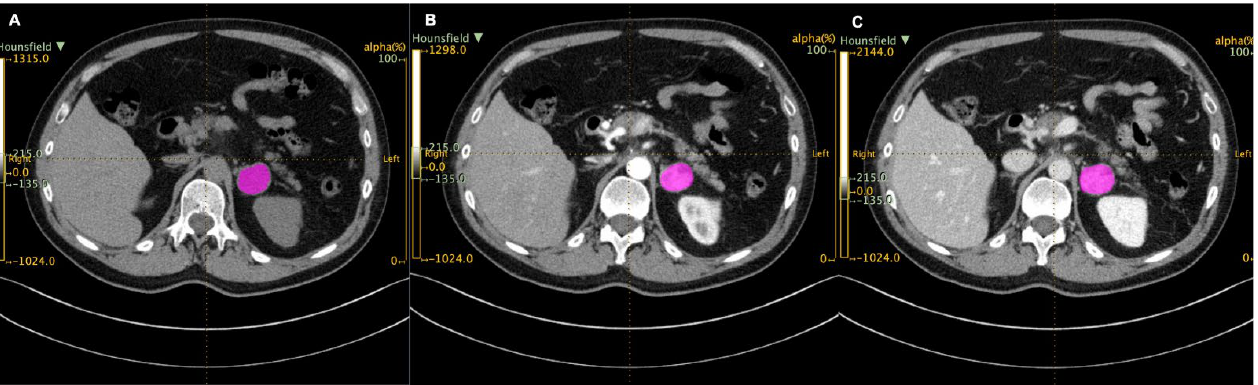
Figure 1. Regions of interest (ROIs, in purple) drawn with LIFEx in unenhanced ( A ), arterial ( B ), and venous ( C ) scans.